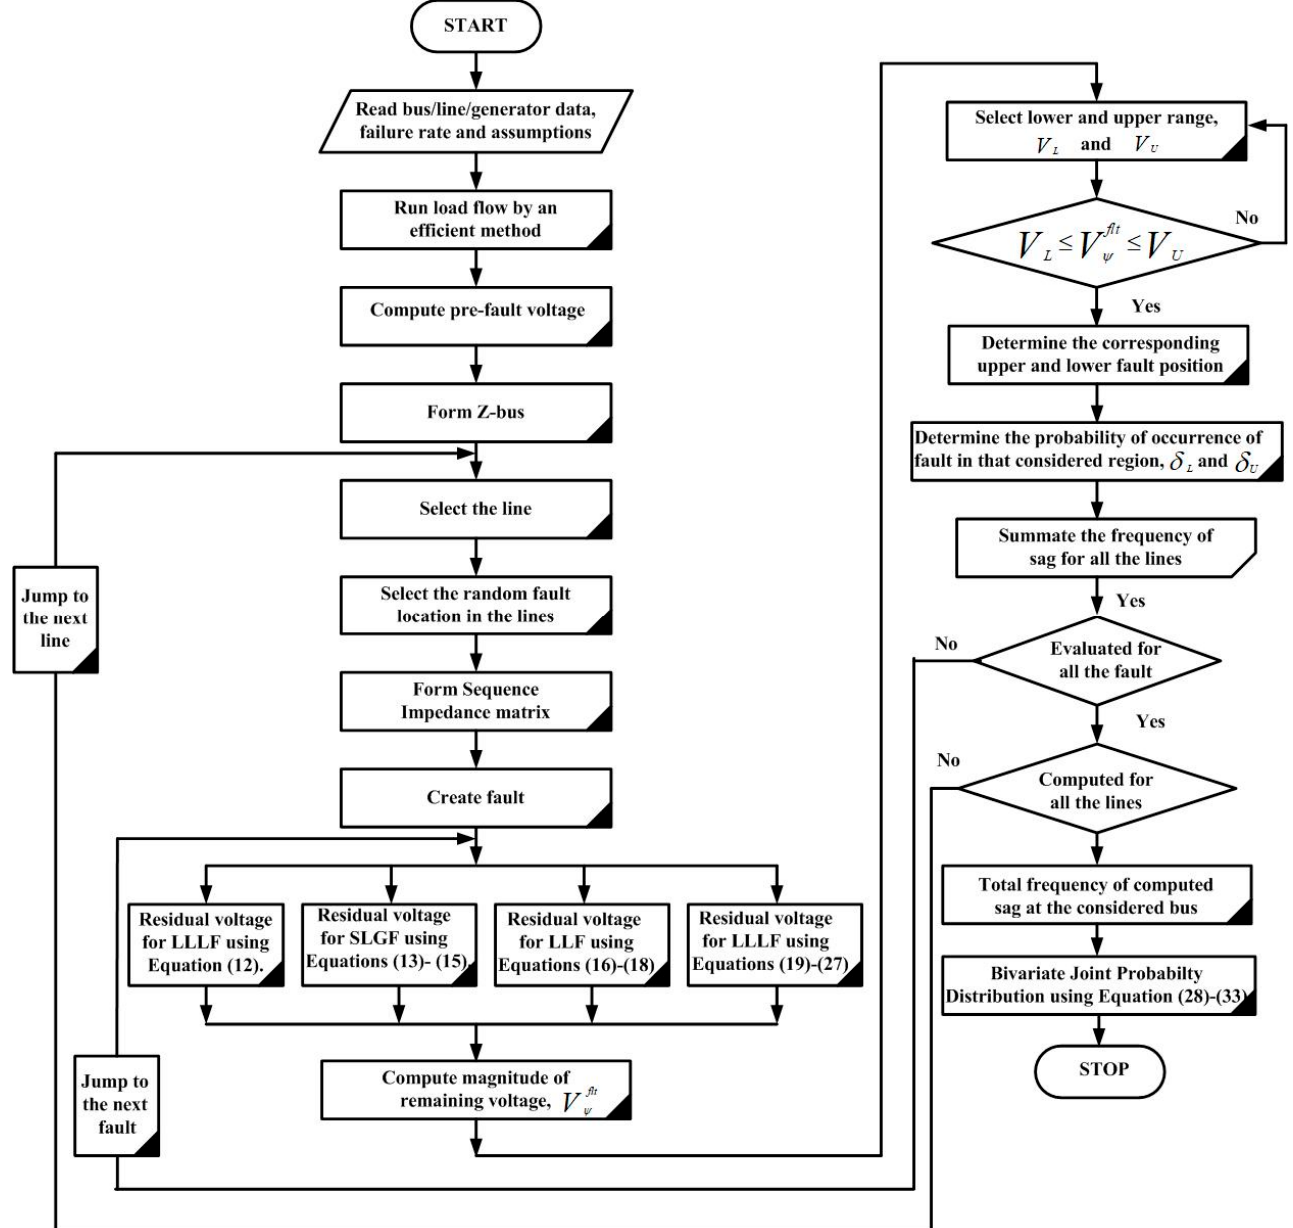
Figure 4. Suggested Methodology for evaluating frequency of sag incorporating efficient load flow technique [25] and bivariate probability distribution [24].